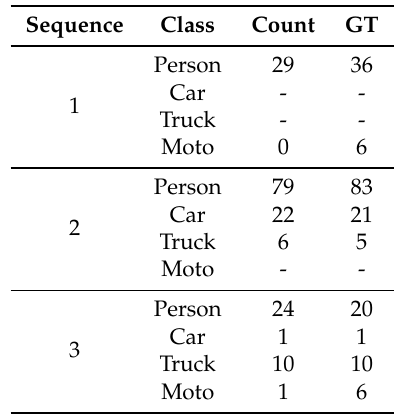
Table 2. Temporal counting on Sequences 1, 2, and 3.